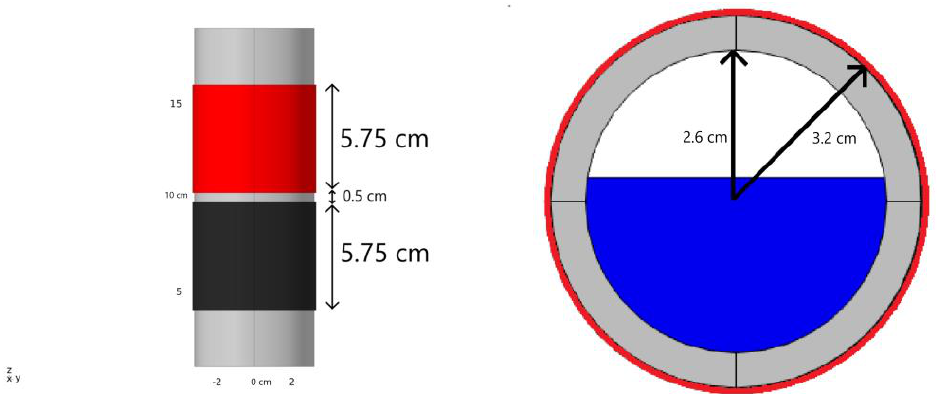
Figure 7. Dimensions of the double-ring designed by COMSOL simulation where the blue color represents the water level, the gray color represents the pipe, and the red and black colors represent the electrodes. Table 3. Measured capacitance values in different void fractions for double-ring sensor using